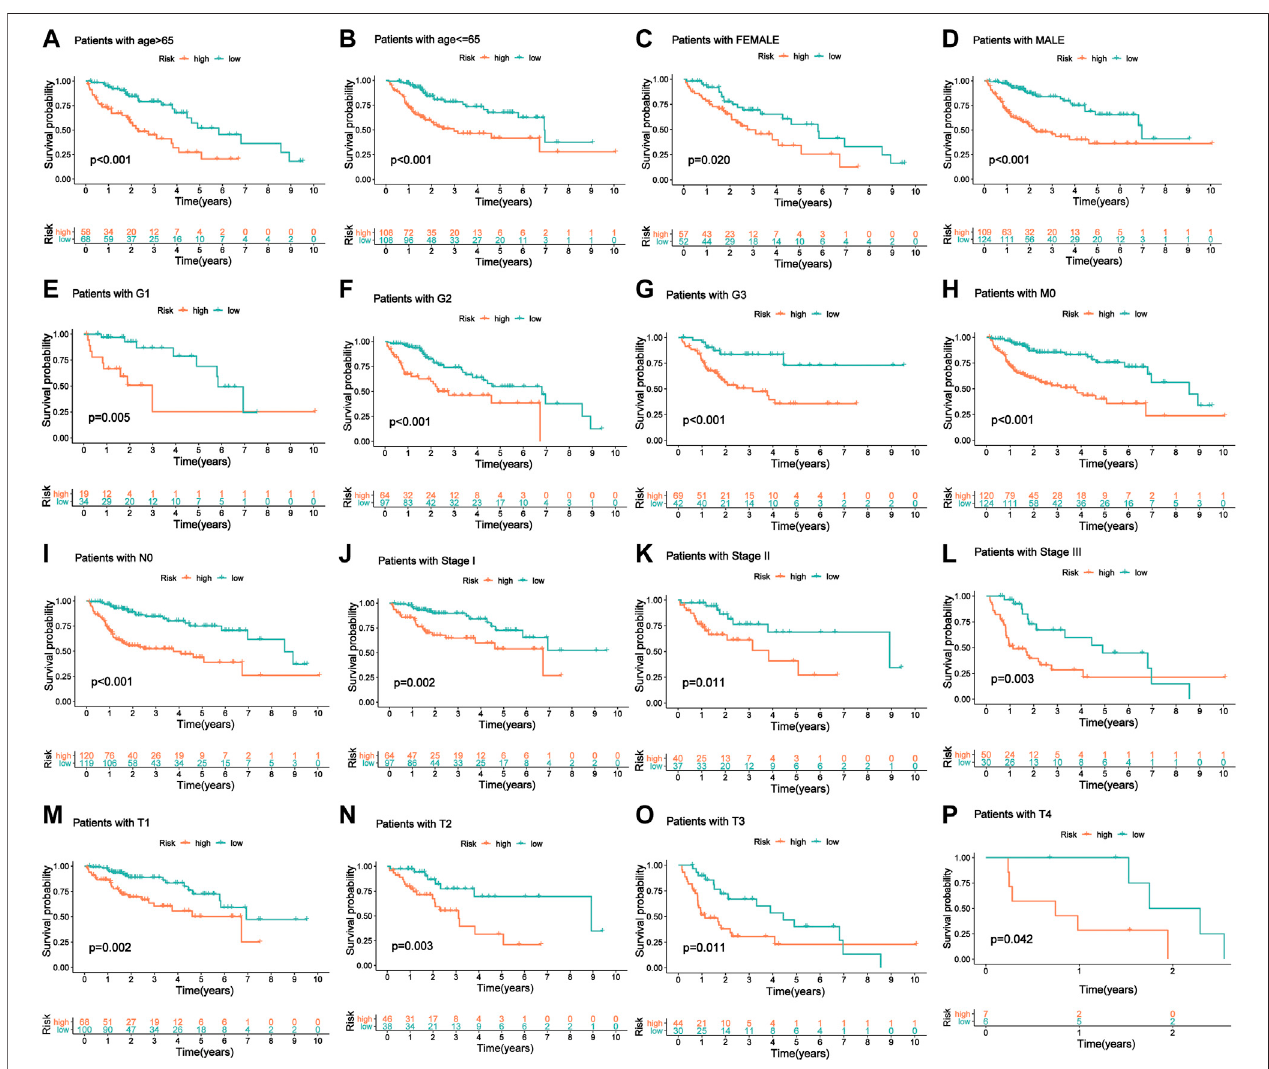
FIGURE 6 | The KM curve of patients with OS strati fi ed by age, gender, and clinical stage according to m6A-9LPS. (A, B) KM curve of the elderly and young patients. (C,D) KMcurveoffemaleandmalepatients. (E – G) KMcurveofG1,G2,andG3stagepatients. (H) KMcurveofpatientswiththeM0stagegroup. (I) KMcurve of patients with the N0 stage group. (J – L) KM curve of stage I, stage II, and stage III groups. (M – P) KM curves of T1, T2, T3, and T4 stage